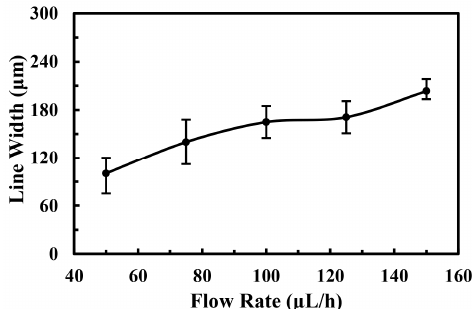
Figure 5. The effect of solution flow rate on the electrospray line width. The applied voltage, the velocity of substrate, the distance between nozzle and collector, and the deposition time were 1.5 kV, 5 mm/s, 5 mm, and 2 s, respectively.